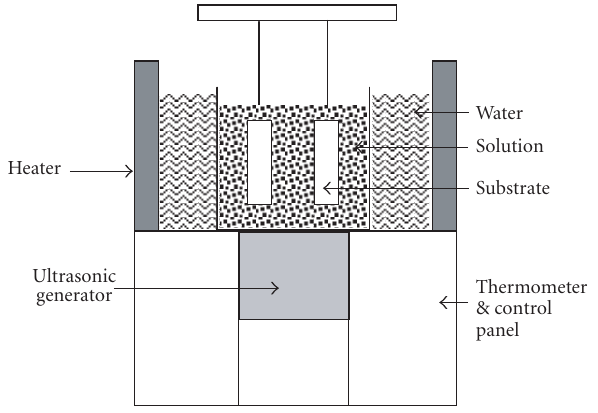
Figure 1: Experimental arrangement of ultrasonical colloid chem- istry deposition method (UCCD).